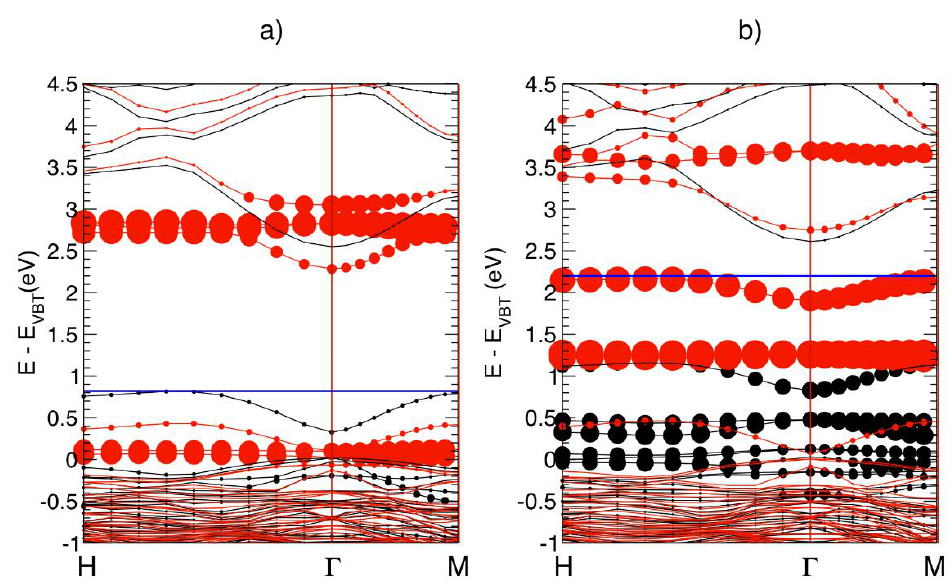
Figure 6. Spin-polarized electronic band structure along the H- Γ -M direction, for the neutral ( a ) and -1-charged ( b ) Co-V O complex in ZnO. Black and red lines correspond the to spin-up and spin-down states, respectively. Circles indicate Co-d contribution to the electronic levels, as circle radii are proportional to the integral of the corresponding charge densities projected on atom-centered orbitals. The horizontal blue line sets the position of the last occupied eigenvalue (Fermi energy). In ( a ), empty levels induced by neutral Co – V O are resonant in the CB, about 0.5 eV higher than the CBM. The zero of the energy scale is the valence band top (E VBT ). Reproduced with permission from [24]. Copyright 2015 Royal Society of Chemistry.